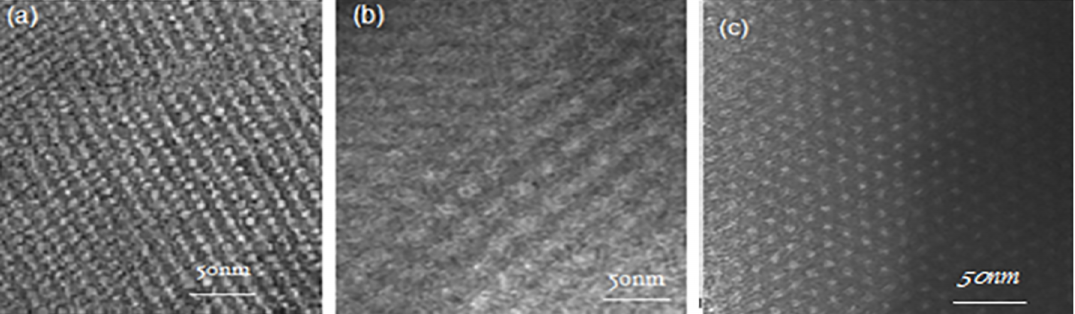
Figure 2. High resolution transmission HR-TEM of calcined samples: (a) MS58 (TEOS/Brij58); (b) MS78 (TEOS/Brij78) and (c) Al-MCM41